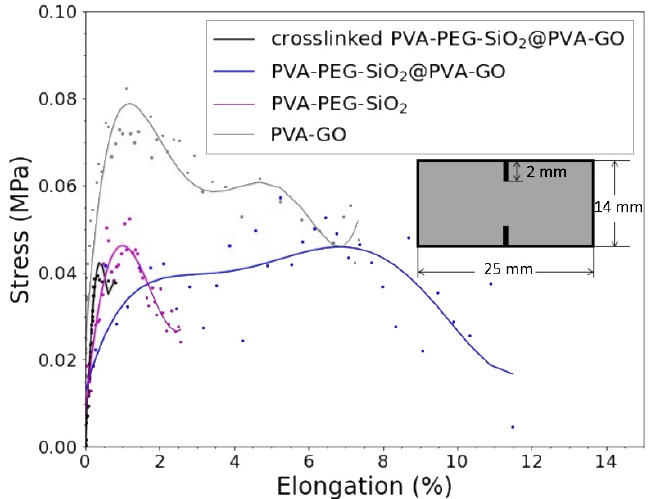
Figure 10. Stress-strain curves of PVA–PEG–SiO 2 @PVA–GO (core-shell), PVA–PEG–SiO 2 (core), and PVA–GO (shell) fibers with the sample design for double edge notch test. The stress-strain curve of the crosslinked PVA–PEG–SiO 2 @PVA–GO demonstrates